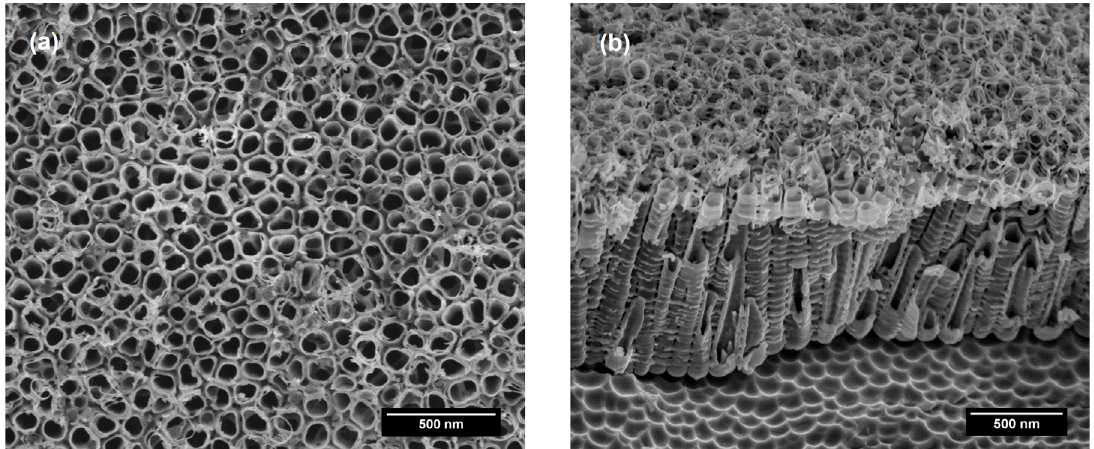
Figure 1. SEM micrographs of CP-Ti after anodization at 20V and 1h: (a) top view and (b)